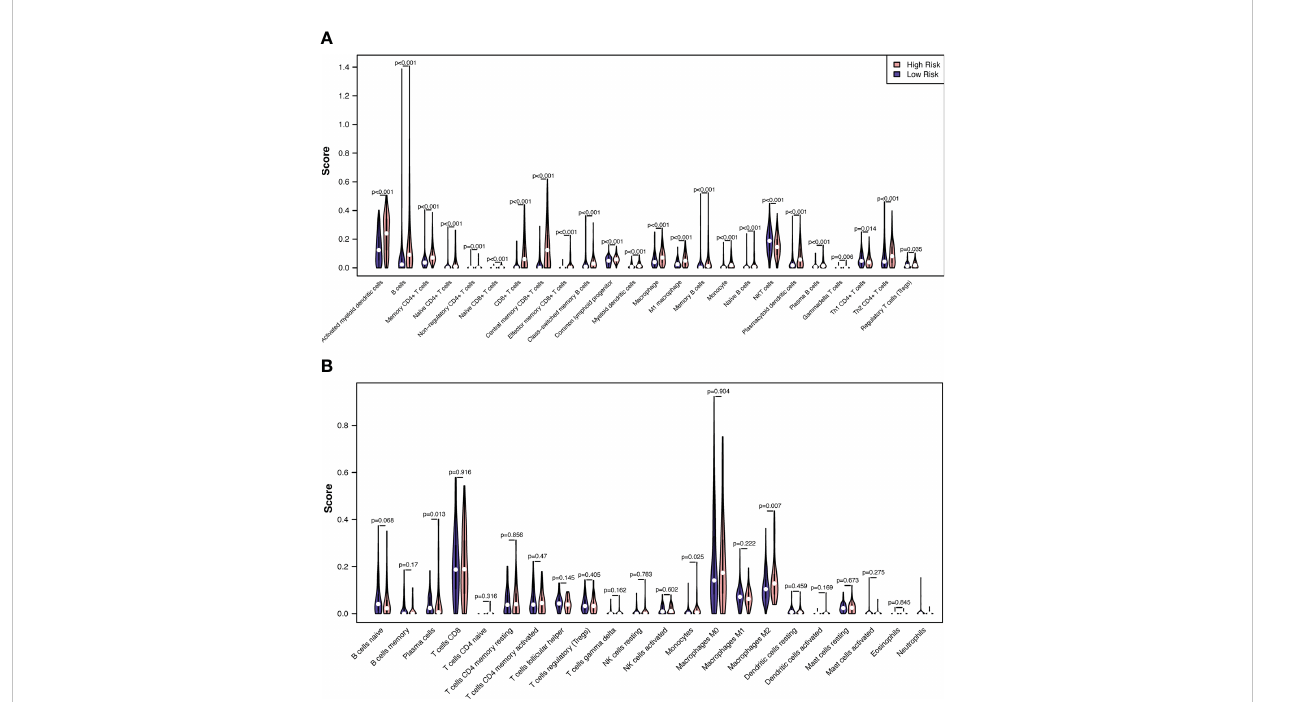
FIGURE 8 Correlations between melanoma RS and tumor immune microenvironment. The proportionate differences in immune and stromal cells between the CSIRG high- and low-risk melanoma patient groups were visualized using a violin plot by the xCell (A) and CIBERSORT (B)